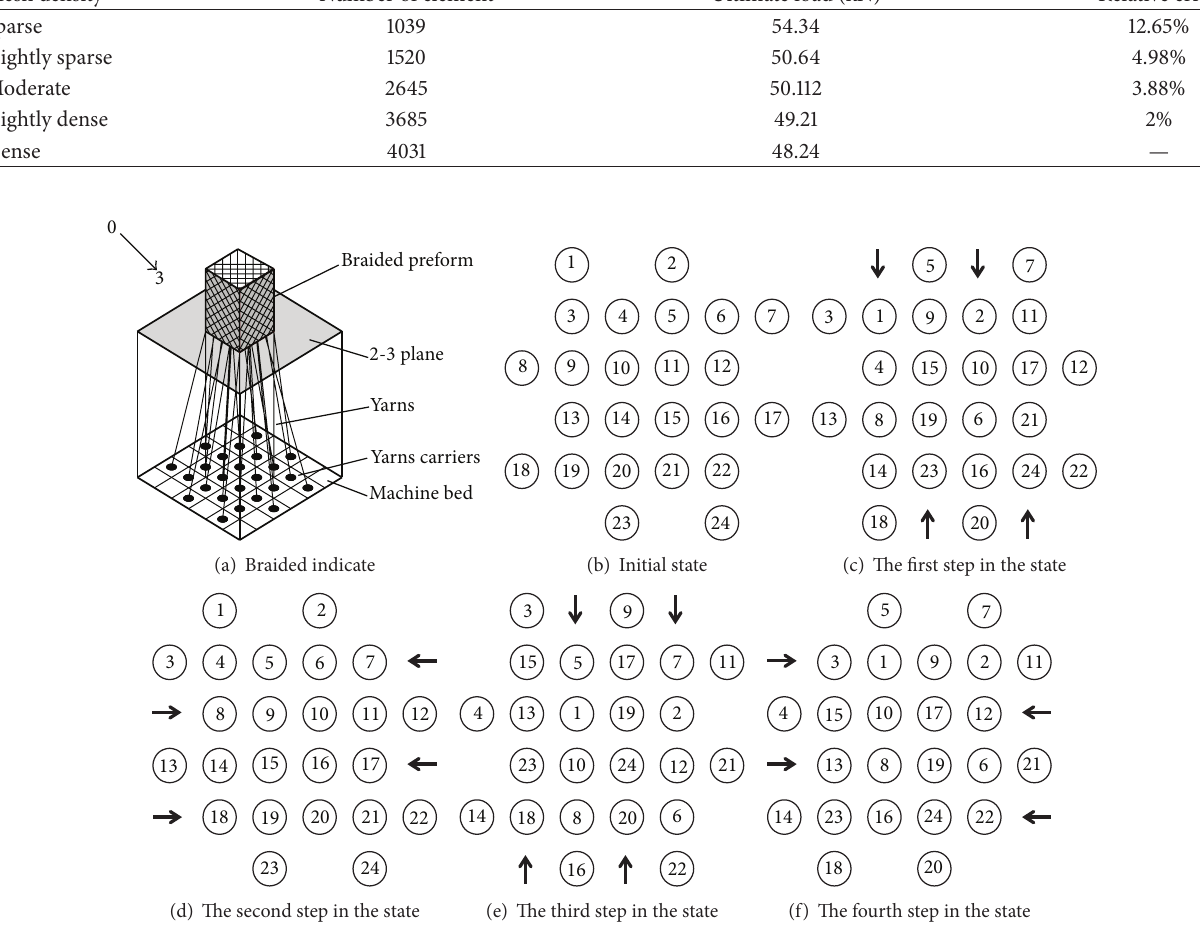
Figure 5: Four-step 1 × 1 3D braided process.